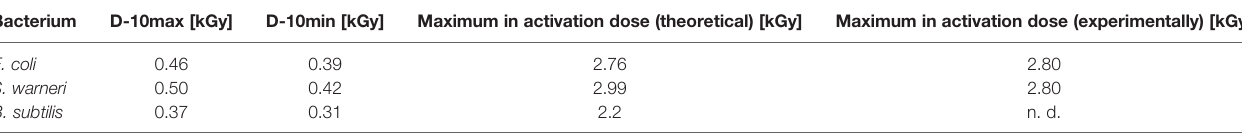
TABLE 2 | D 10 values and the maximum theoretically and experimentally determined inactivation dose values for E. coli , S. warneri , and B. subtilis .